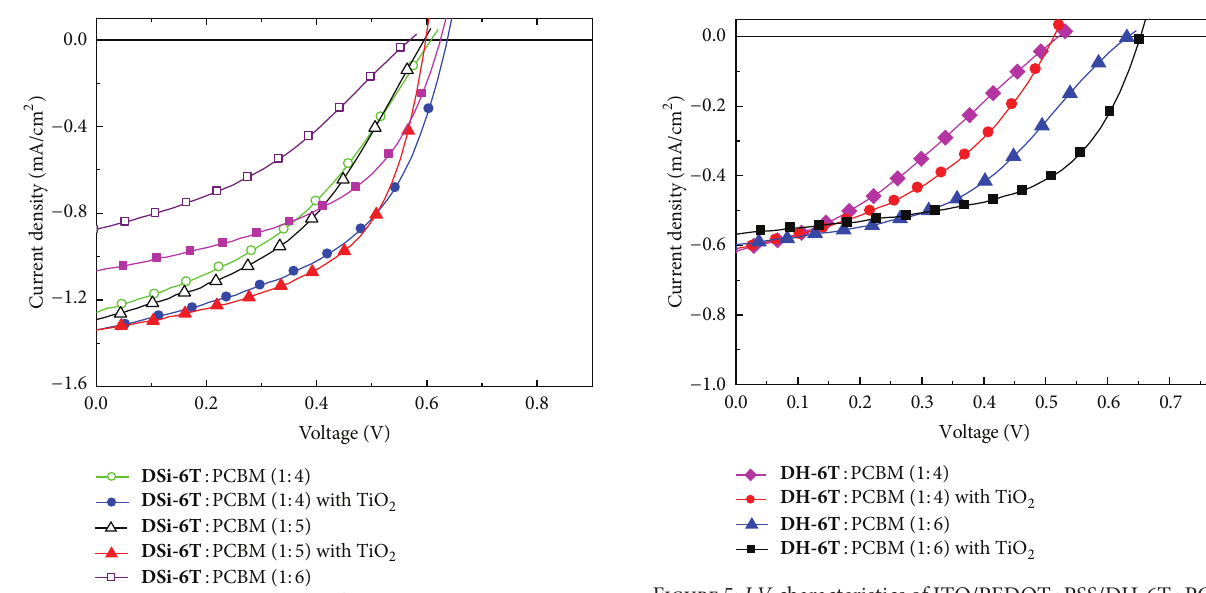
Figure 5: J-V characteristics of ITO/PEDOT:PSS/DH-6T: PCBM/ Al (active layer DH-6T:PCBM 1:4, w/w ( X ), 1:6 w/w ( 󳵳 )) and ITO/PEDOT:PSS/DH-6T: PCBM/TiO 2 /Al (active layer DH- 6T:PCBM 1:4, w/w ( ∙ ), 1:6 w/w ( ◼ )) under illumination of AM 1.5, 100mWcm −2